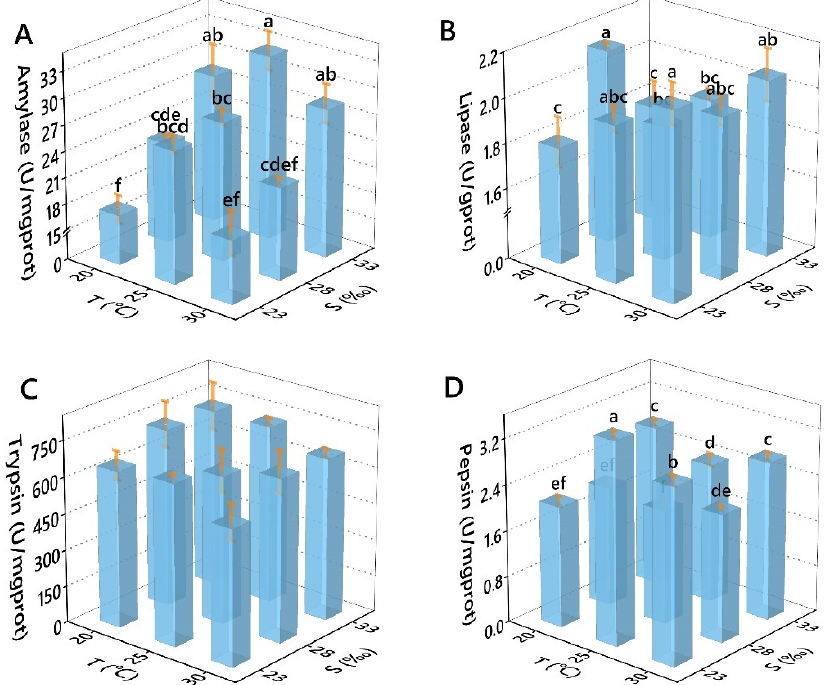
Figure 2. Effects of temperature and salinity on the digestive enzyme activities. (( A ) Amylase, ( B ) Lipase; ( C ) Trypsin; ( D ): Pepsin) of Perna viridis. Different letters indicate significant differences ( p < 0.05).